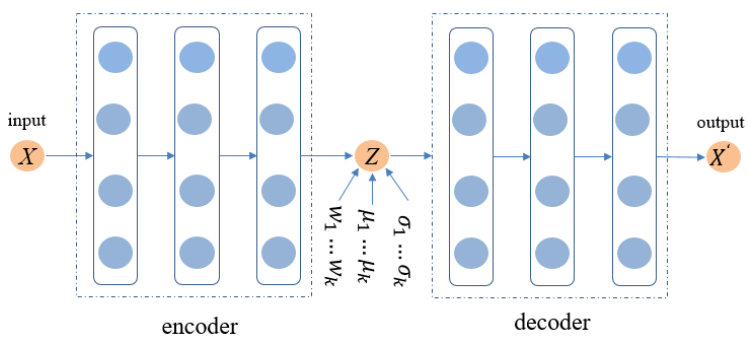
Figure 1. Variational autoencoder based on a Gaussian mixture model